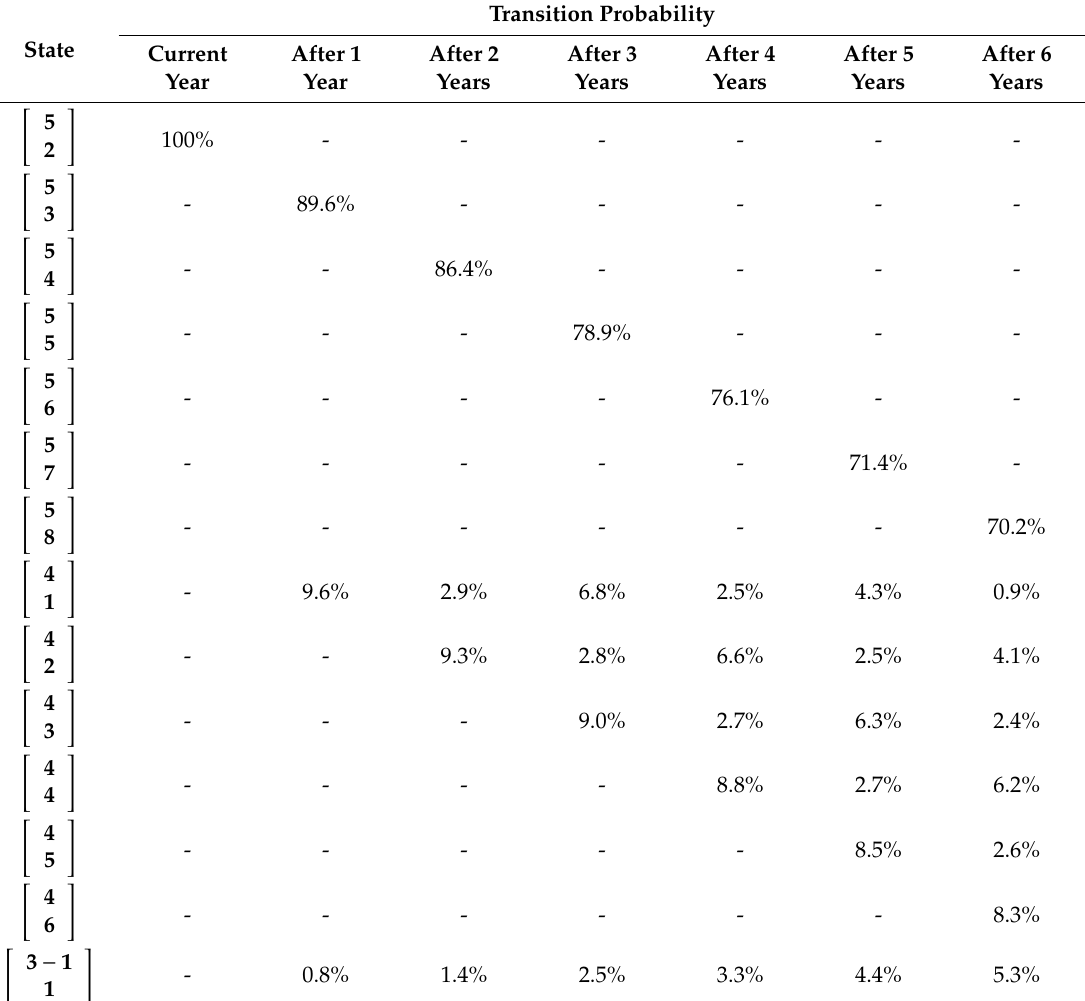
Table 5. Optimal inspection intervals for 5% risk